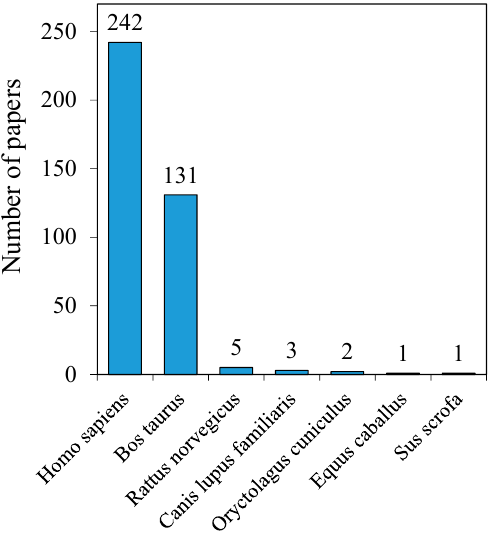
Figure 2. Source organisms of albumin by the number of the original papers cited in the dataset .